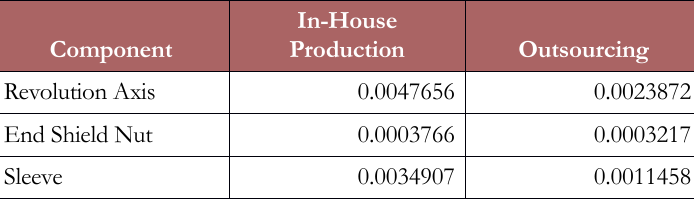
Table 7. Current components